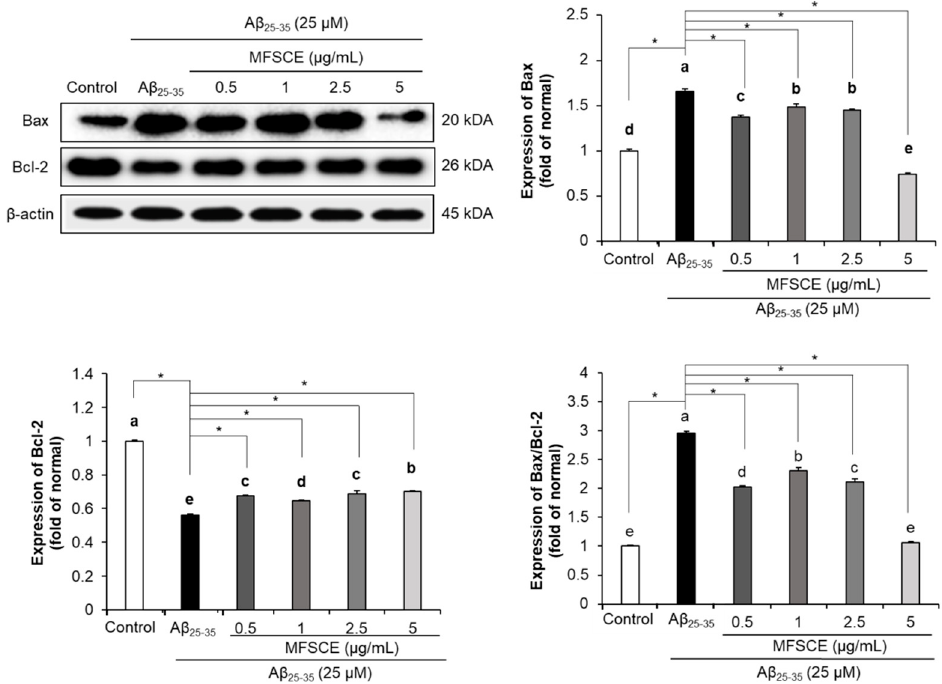
Figure 5. Effect of membrane-free stem cell extract (MFSCE) on neuronal apoptosis-related protein expression in SH-SY5Y cells treated with A β 25–35 . Values are presented as mean ± SD ( n = 6). The different letters (a–e) among groups represent significant differences determined by ANOVA and Duncan’s multiple range test (p < 0.05). * p < 0.05 vs. A β 25–35 -treated cells. β -actin was used as a loading control.